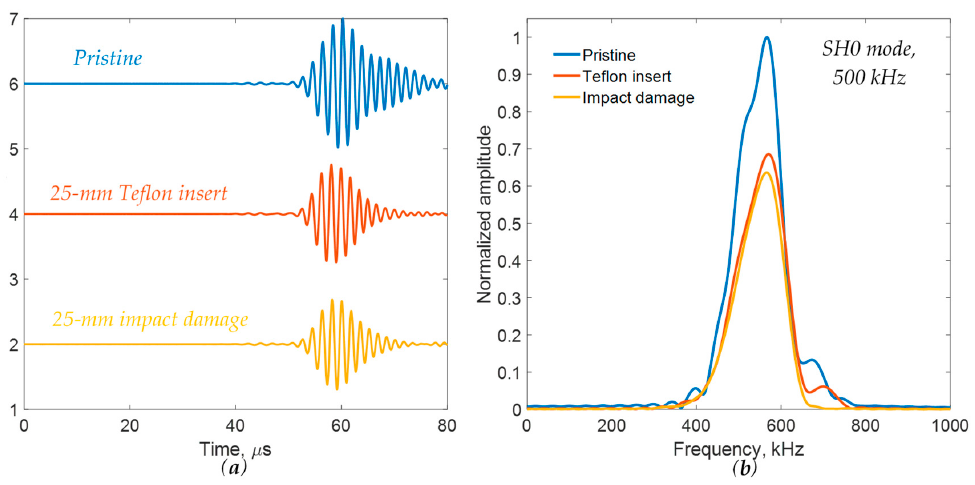
Figure 14. Signal comparison between the pristine area, the Teflon insert, and the impact damage using pure SH0 mode at 500 kHz on a 2-mm quasi-isotropic composite plate: ( a ) time-domain signals; ( b ) frequency spectrums.